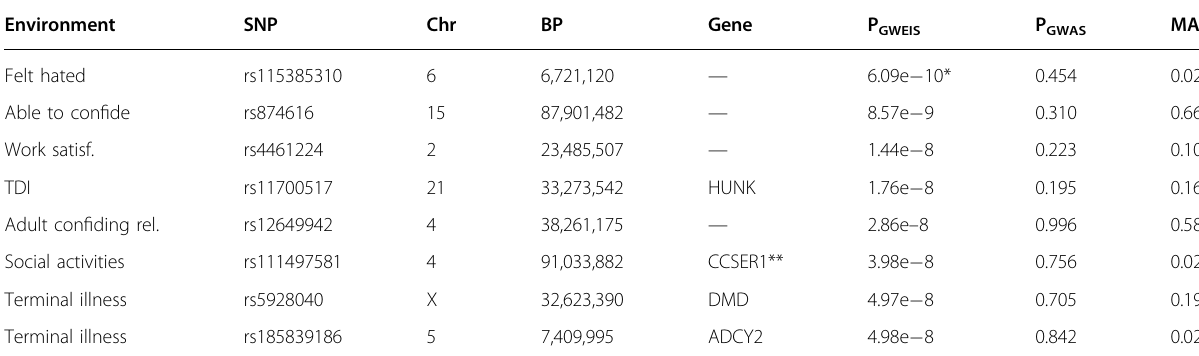
Table 2 SNPs-environment interactions detected in the GWEIS.